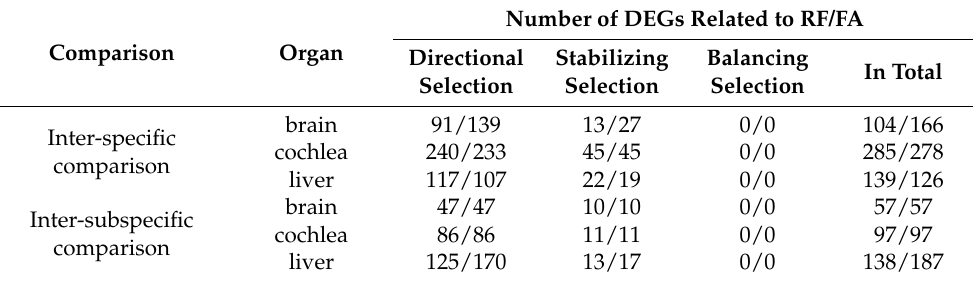
Table 2. Numbers of differentially expressed genes (DEGs) with expression variation related to traits and forced by natural selection in the inter-specific and inter-subspecific comparisons for three organs. RF and FA represent the resting frequency of echolocation calls and forearm length, respectively.